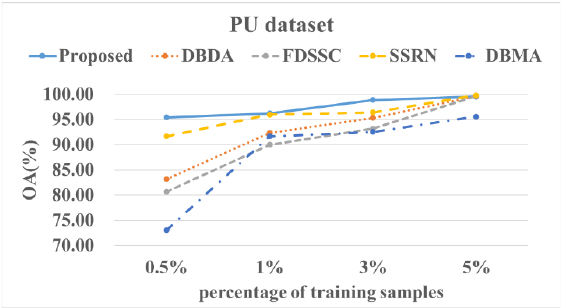
Figure 14. OA results of the different methods from various proportions of training samples using the IP dataset.